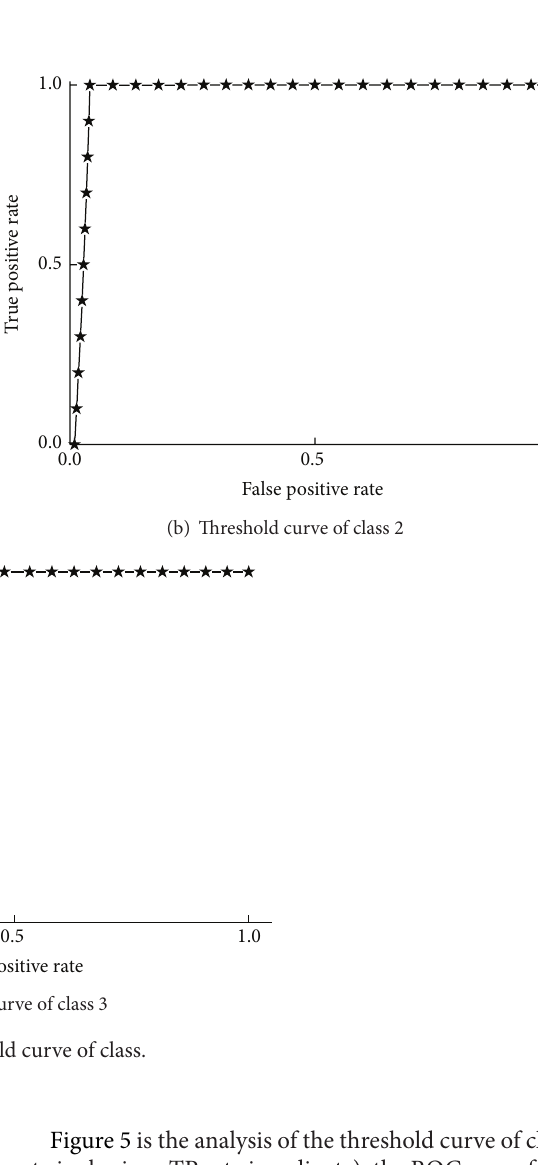
Figure 4: Sample database of three kinds of thin nanocomposite film.